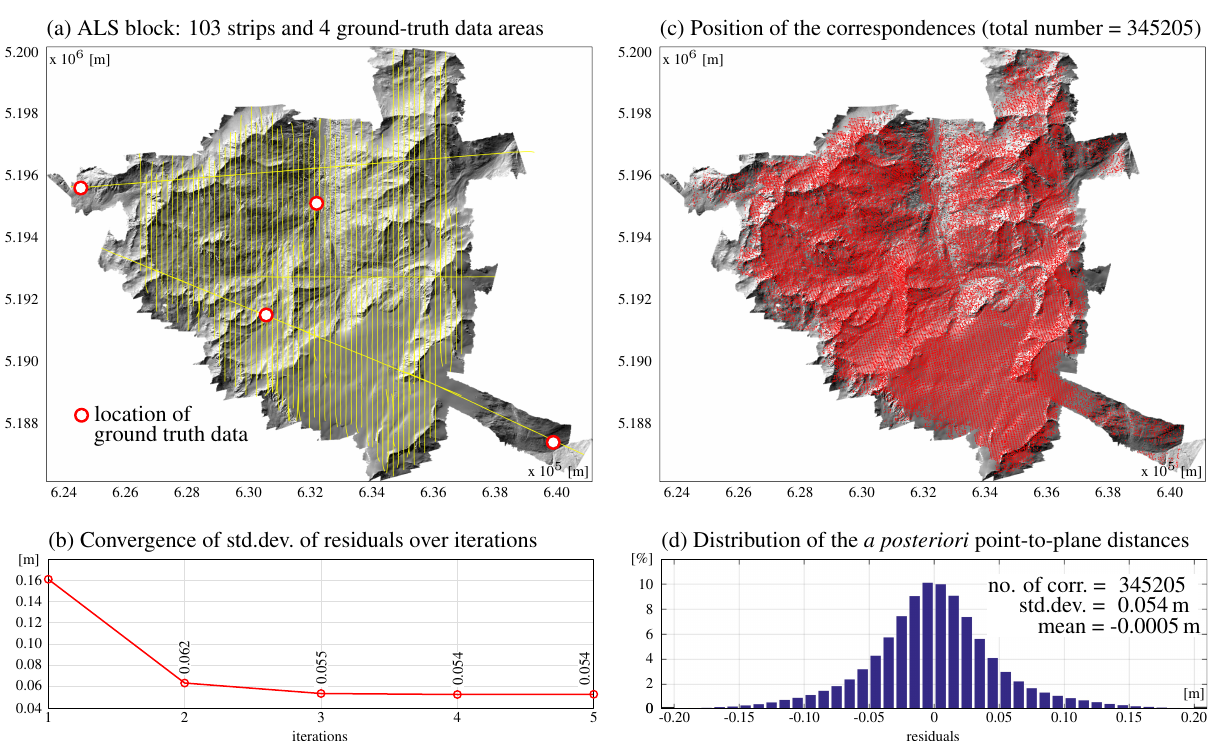
Figure 6: Strip adjustment results for an ALS block covering an area of approx. 119km 2 in the Austrian Alps (Kaunertal). normally distributed, which indicates that systematic errors were